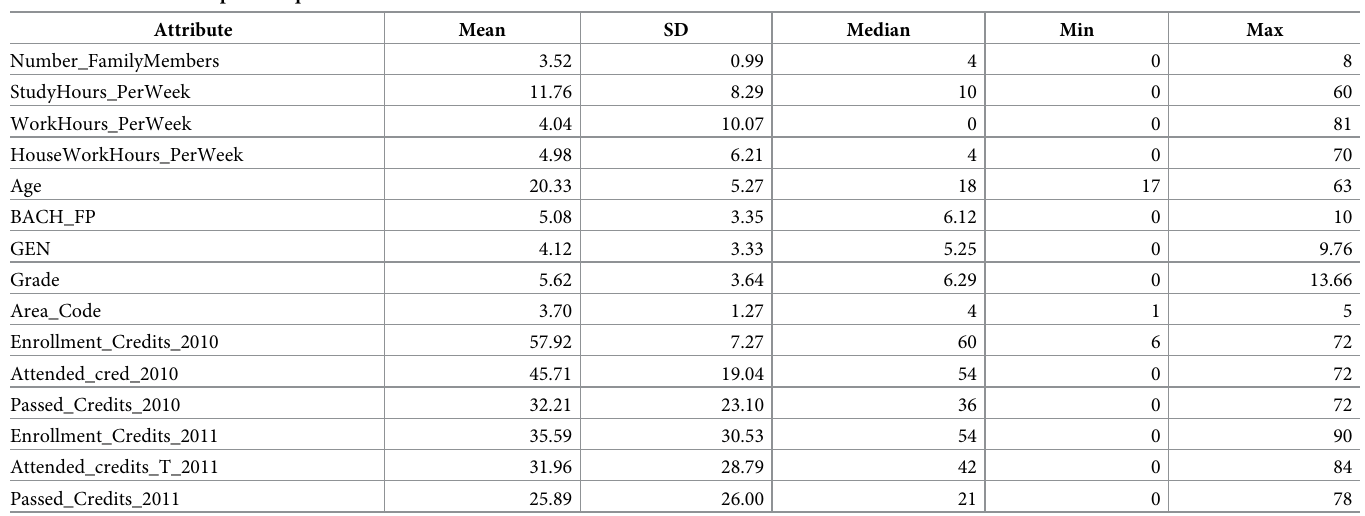
Table 2. Statistical description of quantitative